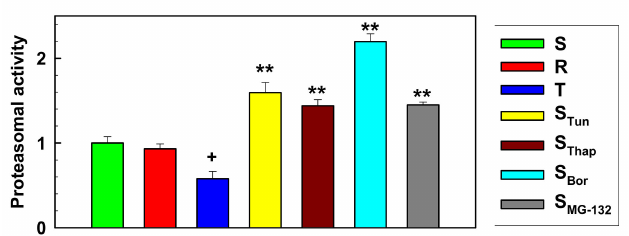
Figure 6. Proteasome activity as measured using the Proteasome Activity Assay Kit (ab107921). Data represent the computed value ± S D according to the linear regressions in Figure S2 (in Supplementary files) for three independent measurements. Significance: Values are higher or lower than the corresponding values obtained for the S cell variant at ** p < 0.01 or + p < 0.05.